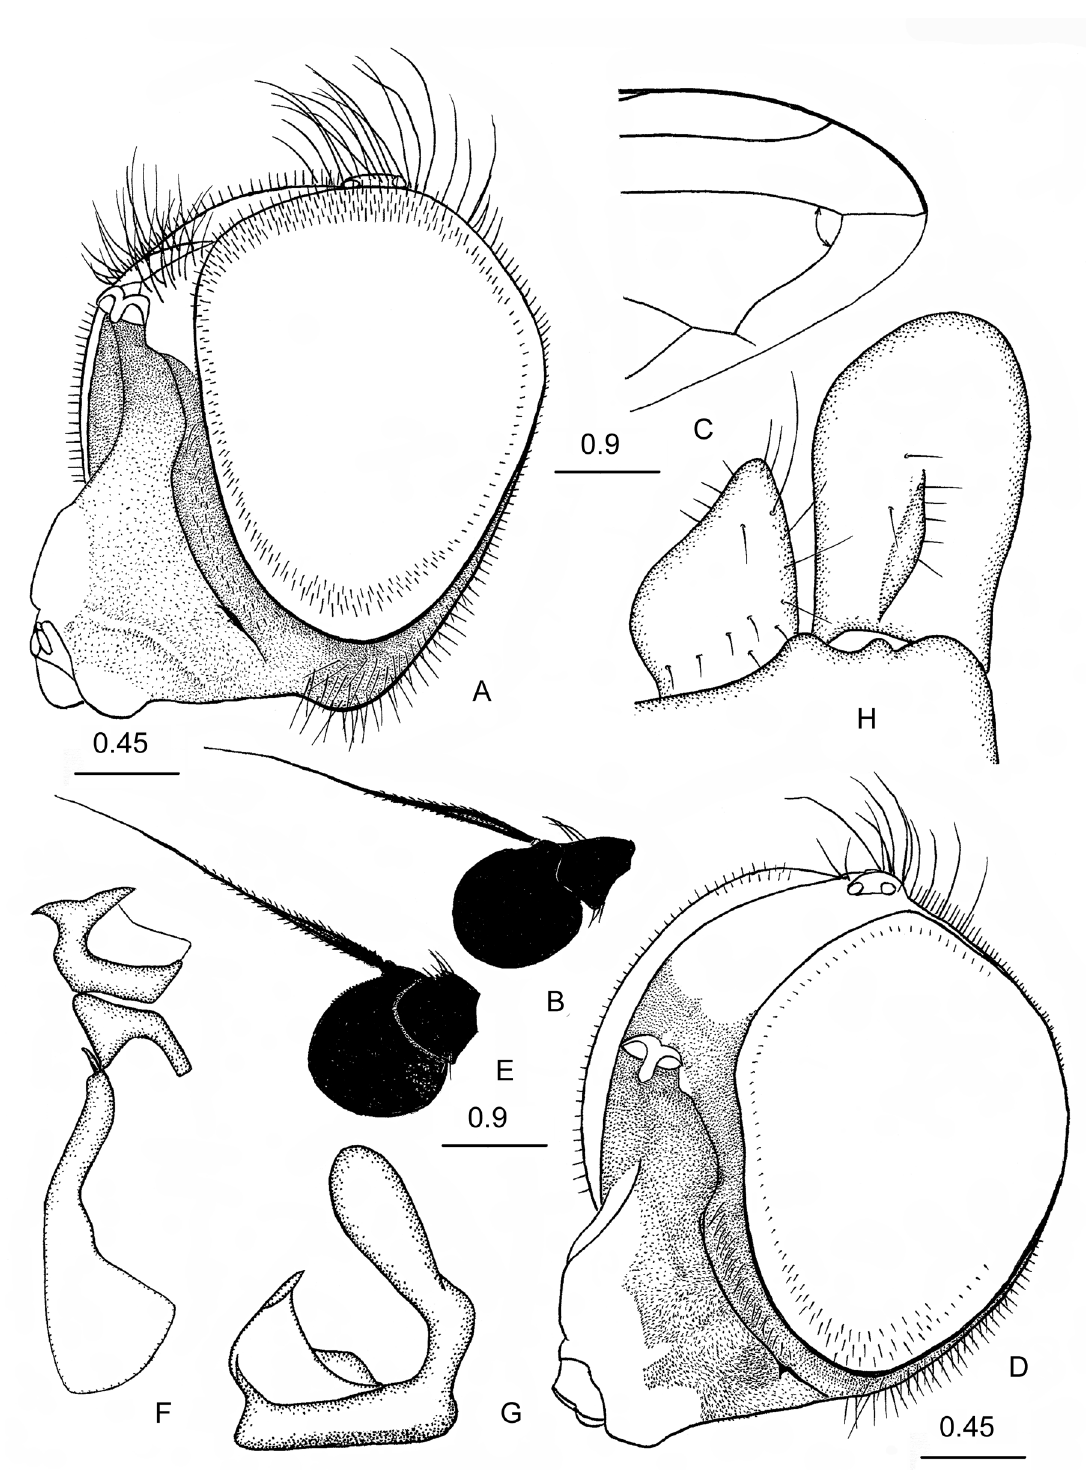
Fig. 66. Cheilosia ( Cheilosia ) weiperti sp. nov.; A–C, F–H = holotype, ♂ (BSJW/NME), D–E = paratype ♀ (BSJW/NME). A, D . Head, lateral view. B, E . Antenna, lateral view of pedicel and basoflagellomere. C . Tip of wing (bent arrow?). F . Aedeagus and aedeagal apodeme, lateral view. G . Superior lobe of hypandrium, lateral view. H . Surstylus and gonocercus, lateral view. Scale bars indicated in